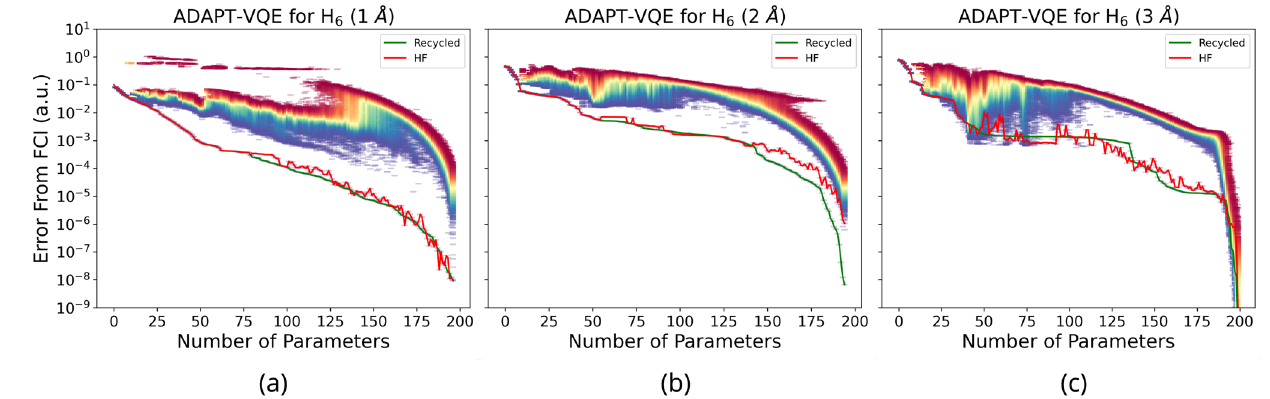
Fig. 3 ADAPT-VQE results for H 6 . The axes and colors are as in Fig. 1. Plots a , b , and c correspond to bond lengths 1, 2, and 3 Å respectively.